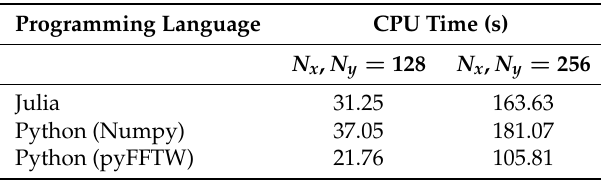
Table 4. Comparison of CPU time for Julia and Python version of pseudo-spectral solver at two grid resolutions. We highlight that the codes are not written for optimization purpose and the CPU time may not be the optimal time that can be achieved for each of the programming